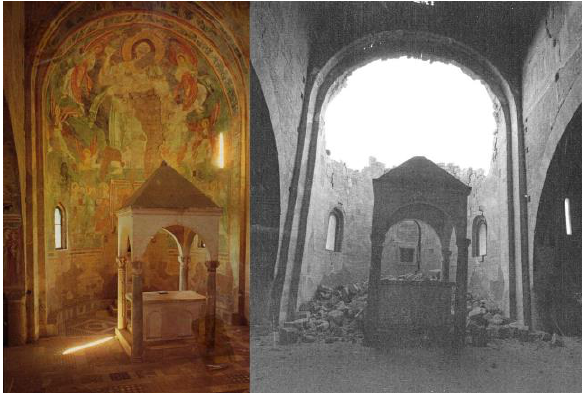
Figure 2. On the left, the apse of the Basilica of San Pietro in Tuscania before the earthquake of 1971. On the right, the collapsed dome after the earthquake that struck the